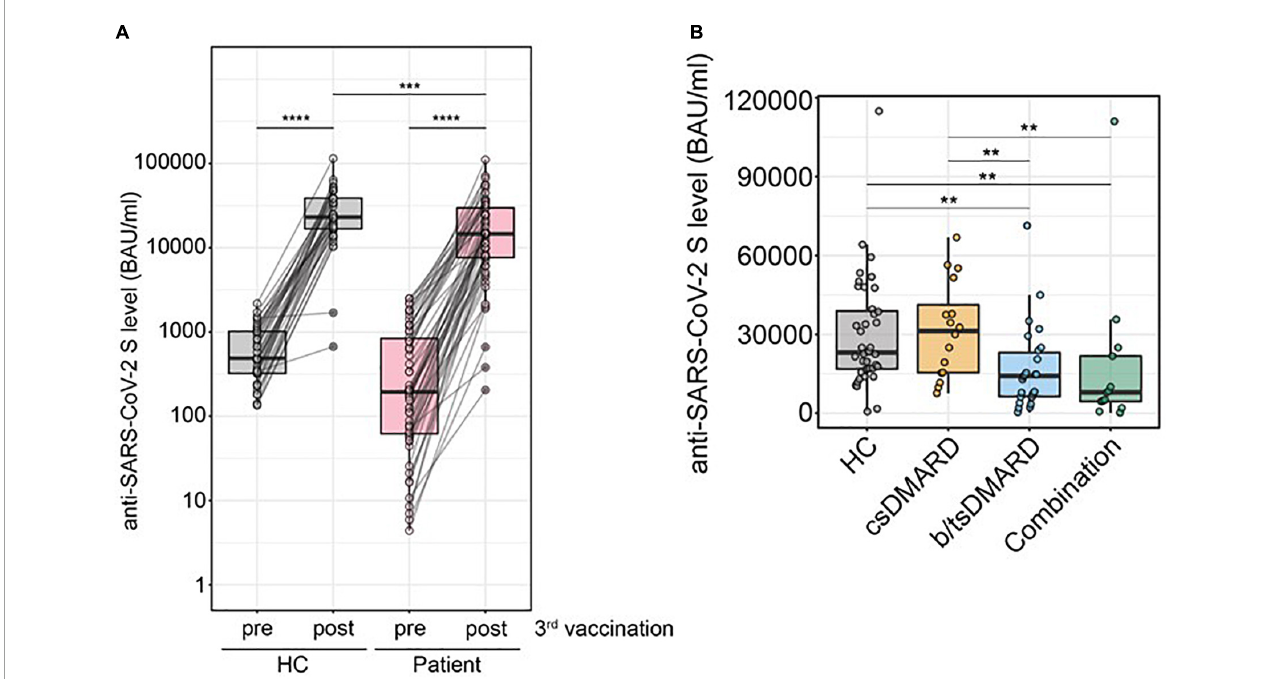
FIGURE4 (A) Comparison of anti-SARS-CoV-2 S antibody levels before and after a third immunization with an mRNA vaccination in HC ( n = 40) vs. patients ( n = 58) (Mann–Whitney U -test). (B) Anti-SARS-CoV-2 S antibody levels after the third immunization of patients with Inflammatory arthritis ( n = 38) and inflammatory bowel disease (IBD; n = 20) receiving csDMARDs ( n = 16), b/tsDMARDs ( n = 26), or a combination of both ( n = 13). Statistics used: Kruskal–Wallis test and subsequent Dunn’s test. ns: non significant p > 0.05; * p ≤ 0.05; ** p ≤ 0.01; *** p ≤ 0.005; and **** p ≤